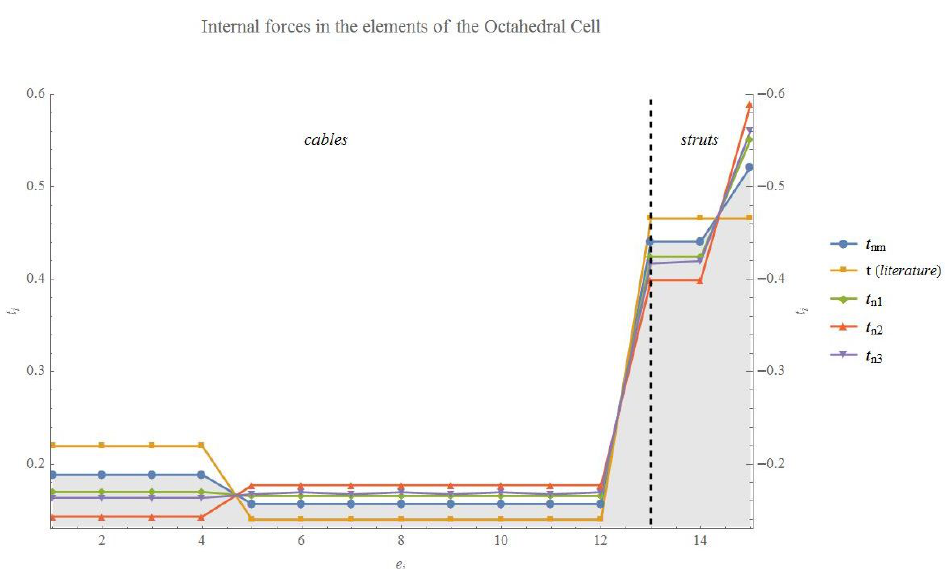
Figure 11: Internal forces in the elements of the Octahedral cell as the axial stiffness of the elements vary (note that the origin of the vertical axes is 0.13)